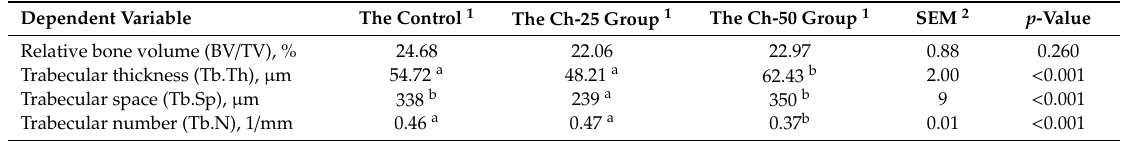
Table 6. Trabecular bone morphology of tibia of 16-week-old male pheasants. Dependent Variable